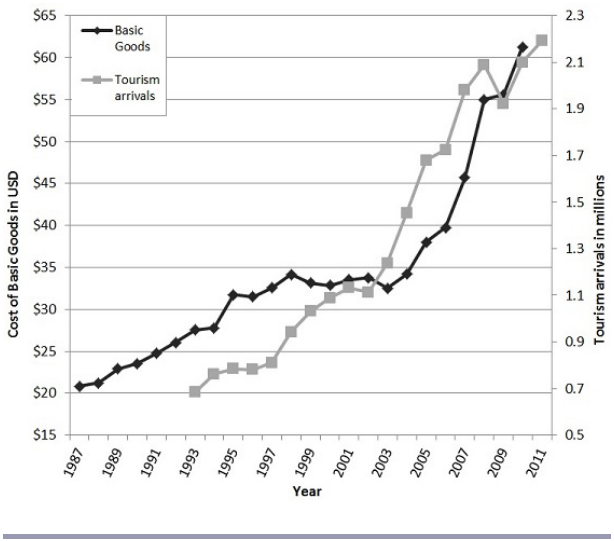
Fig. 2 . The number of tourist arrivals per year to Costa Rica and the cost of basic goods have followed similar trajectories in recent years. Tourism data are reported as millions of visitors per year. The cost of a basic “basket” of goods indicates, on average for the given year, how much money was necessary per person per month to fulfill basic food needs. The cost has been converted to US dollars using the annual average conversion rate for the corresponding year. Tourism data were not available prior to 1993. Note: Figure is constructed using the “Canasta Básica Alimentaria, base 1995” data available from the Instituto Nacional de Estadística y Censos (INEC), Costa Rica (http://www.inec.go.cr). Data is based on the “Encuesta Nacional de Ingresos y Gastos de los Hogares 1987-1988” y la “Encuesta de Nutición, Evaluación Dietética de 1978,” adjusted yearly for price changes in the cost of the identified basic goods. The exchange rate was averaged using data available from the Banco Central de Costa Rica (http://www. bccr.fi.cr). Tourism data is from the “Anuario Estadístico del Turismo, ICT” published via